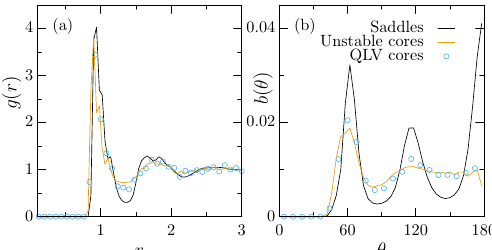
Figure 10: (a) Radial distribution function g ( r ) and (b) bond-angle distribution func- tions b ( θ ) for small particles (black), for small particles at the core of unstable modes (orange) for saddles sampled at T = 0.28, and for small particles at the core of the QLVs (symbol) for local minima at the same